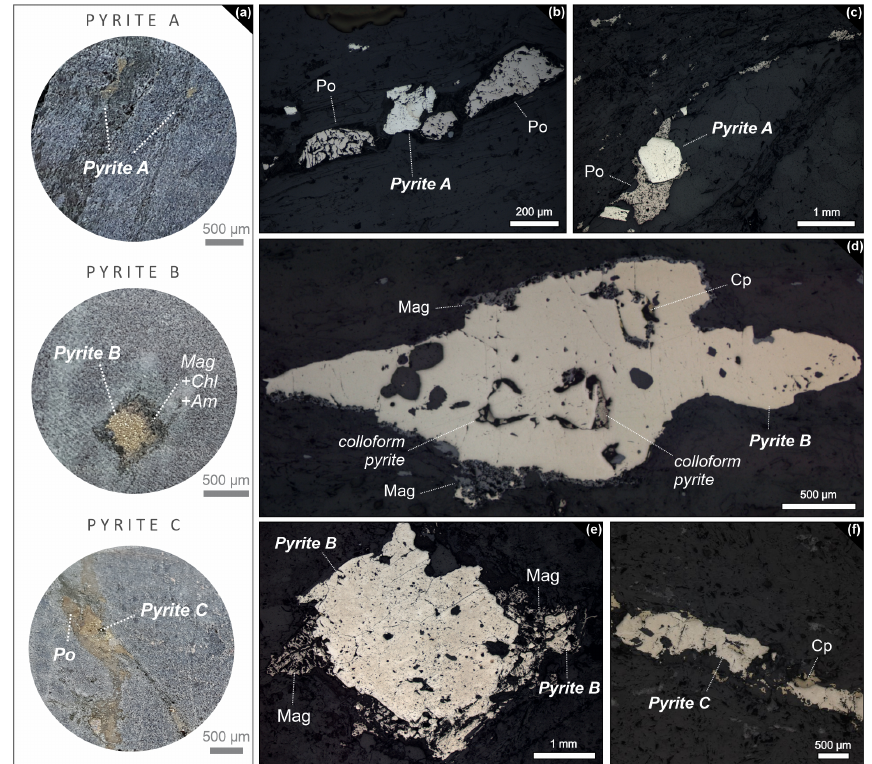
Figure 4. Textural setting of three distinct pyrite types. (a) Circled figures on the left show their occurrence in hand specimen. Reflected light photomicrographs show (b) and (c) pyrite A surrounded by fringe-shaped pyrrhotite following the foliation of the host rock; (d) and (e) show pyrite B porphyroclasts with magnetite (mag)–amphibole–chlorite fringes and (f) fracture-filling pyrite C associated with chalcopyrite (cp).